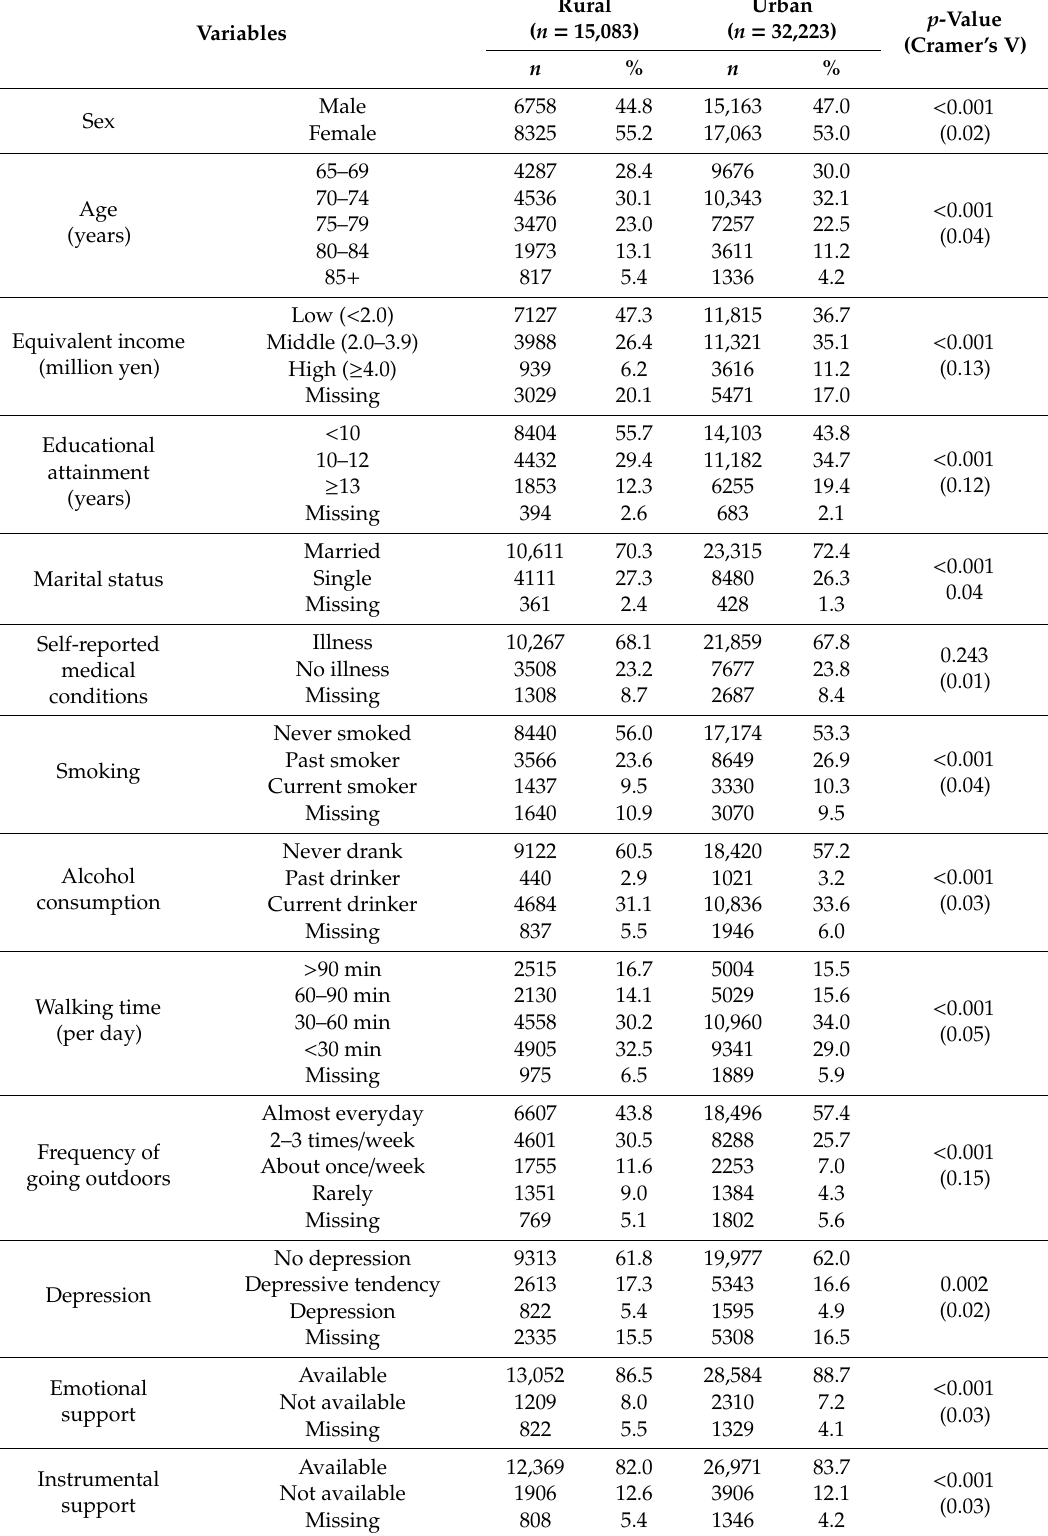
Table 1. Baseline characteristics of respondents